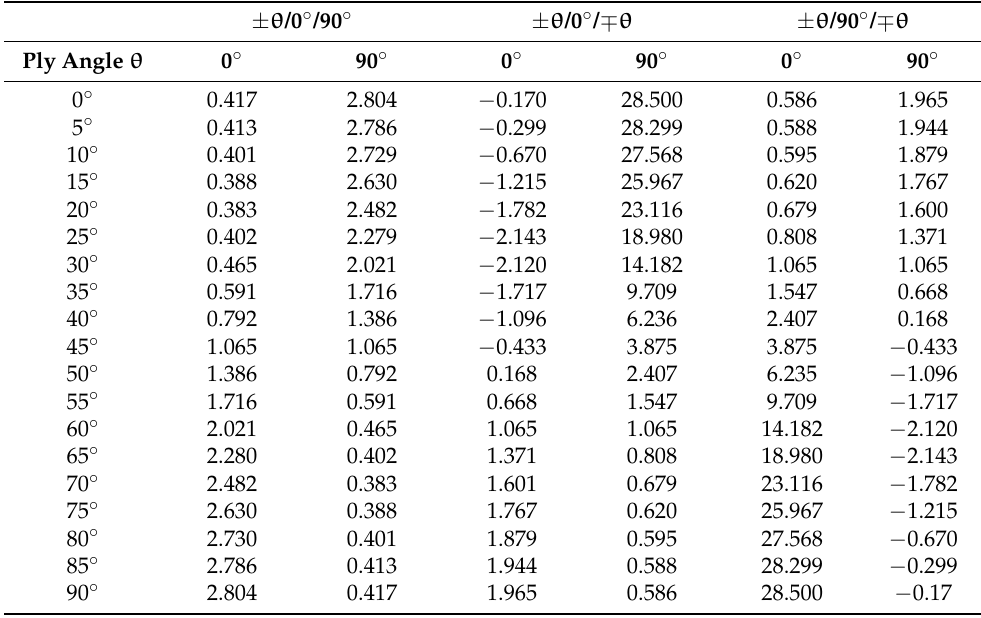
Table 2. Coefficient of thermal expansion with respect to different plying angle under 3 kinds of plying styles ( × 10 − 6 / ◦ C).